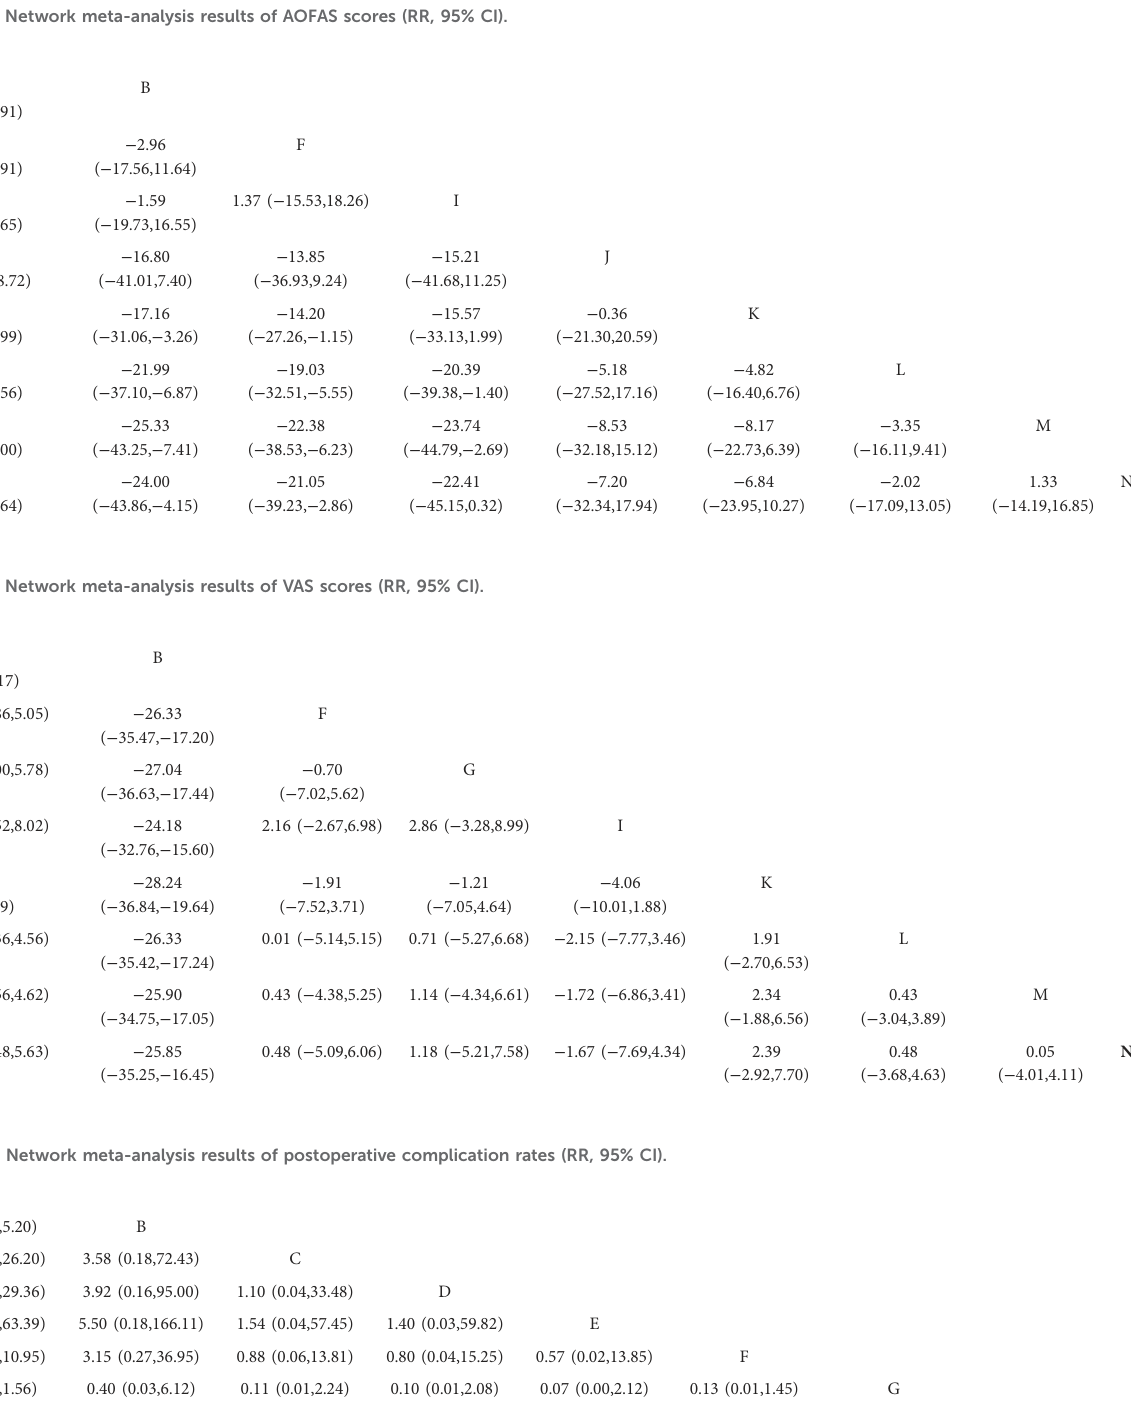
TABLE 2 Network meta-analysis results of AOFAS scores (RR, 95% CI).